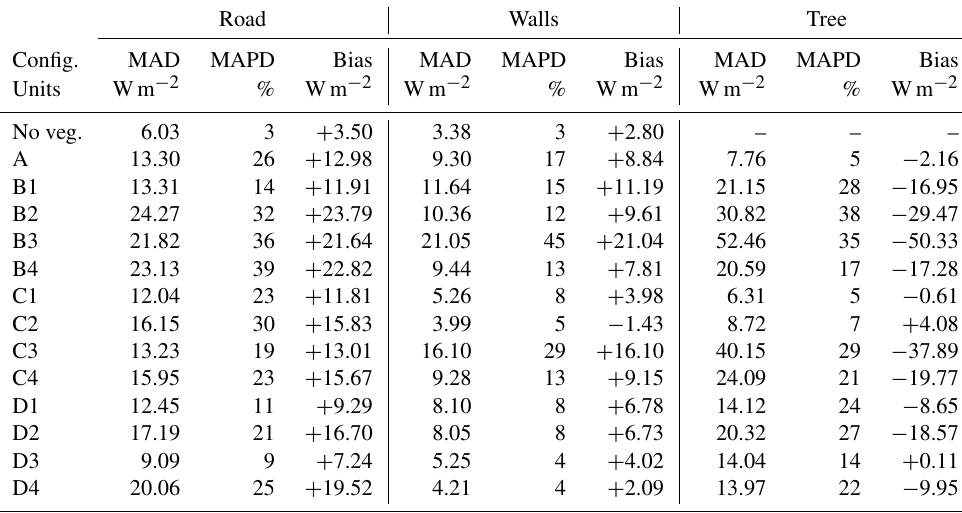
Table 6. Statistical scores for total shortwave radiation absorbed by surfaces after multiple reflections for summertime. Road Walls Tree Config. MAD MAPD Bias MAD MAPD